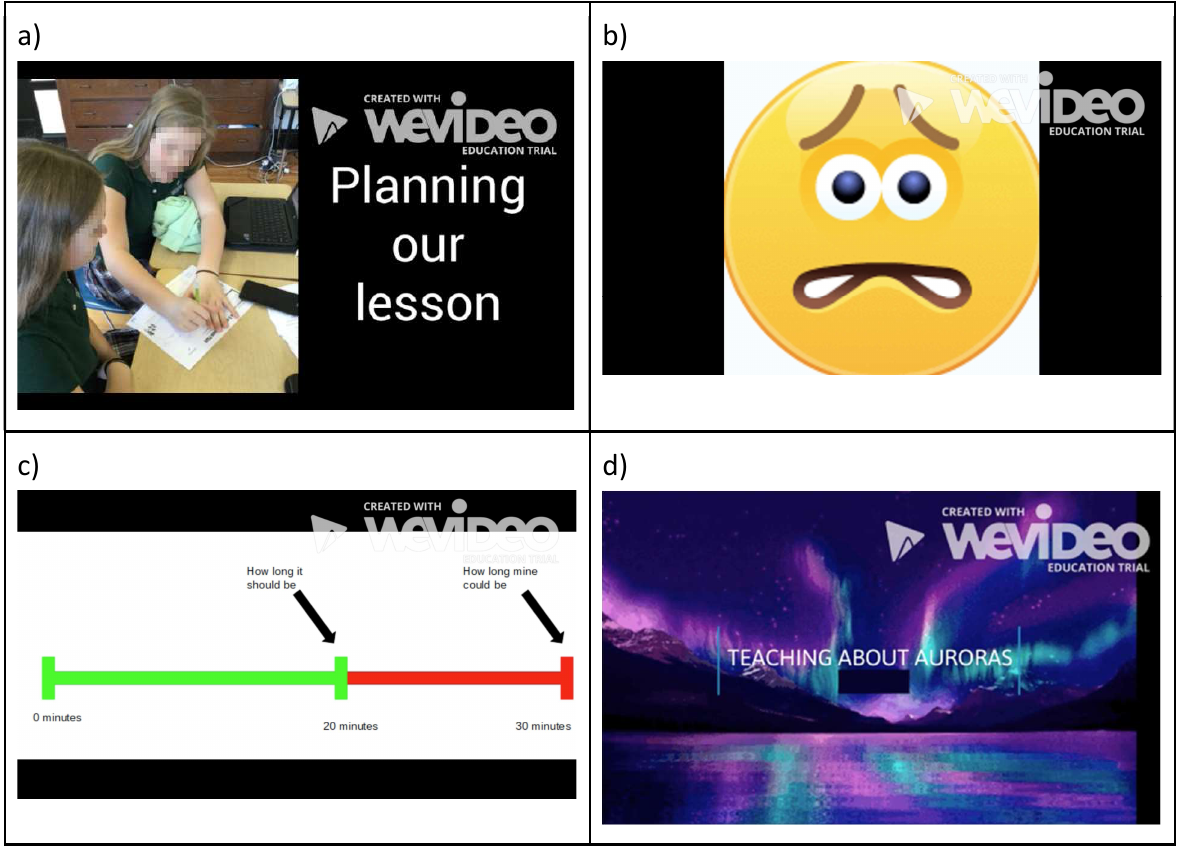
Figure 2: Images from student digital stories; (a) Use of photographs in Vera’s digital story, (b) Use of emojis in Rachel’s digital story, (c) Use of student-created images in Rachel’s story, (d) Use of a GIF on the title slide in Gabby’s digital